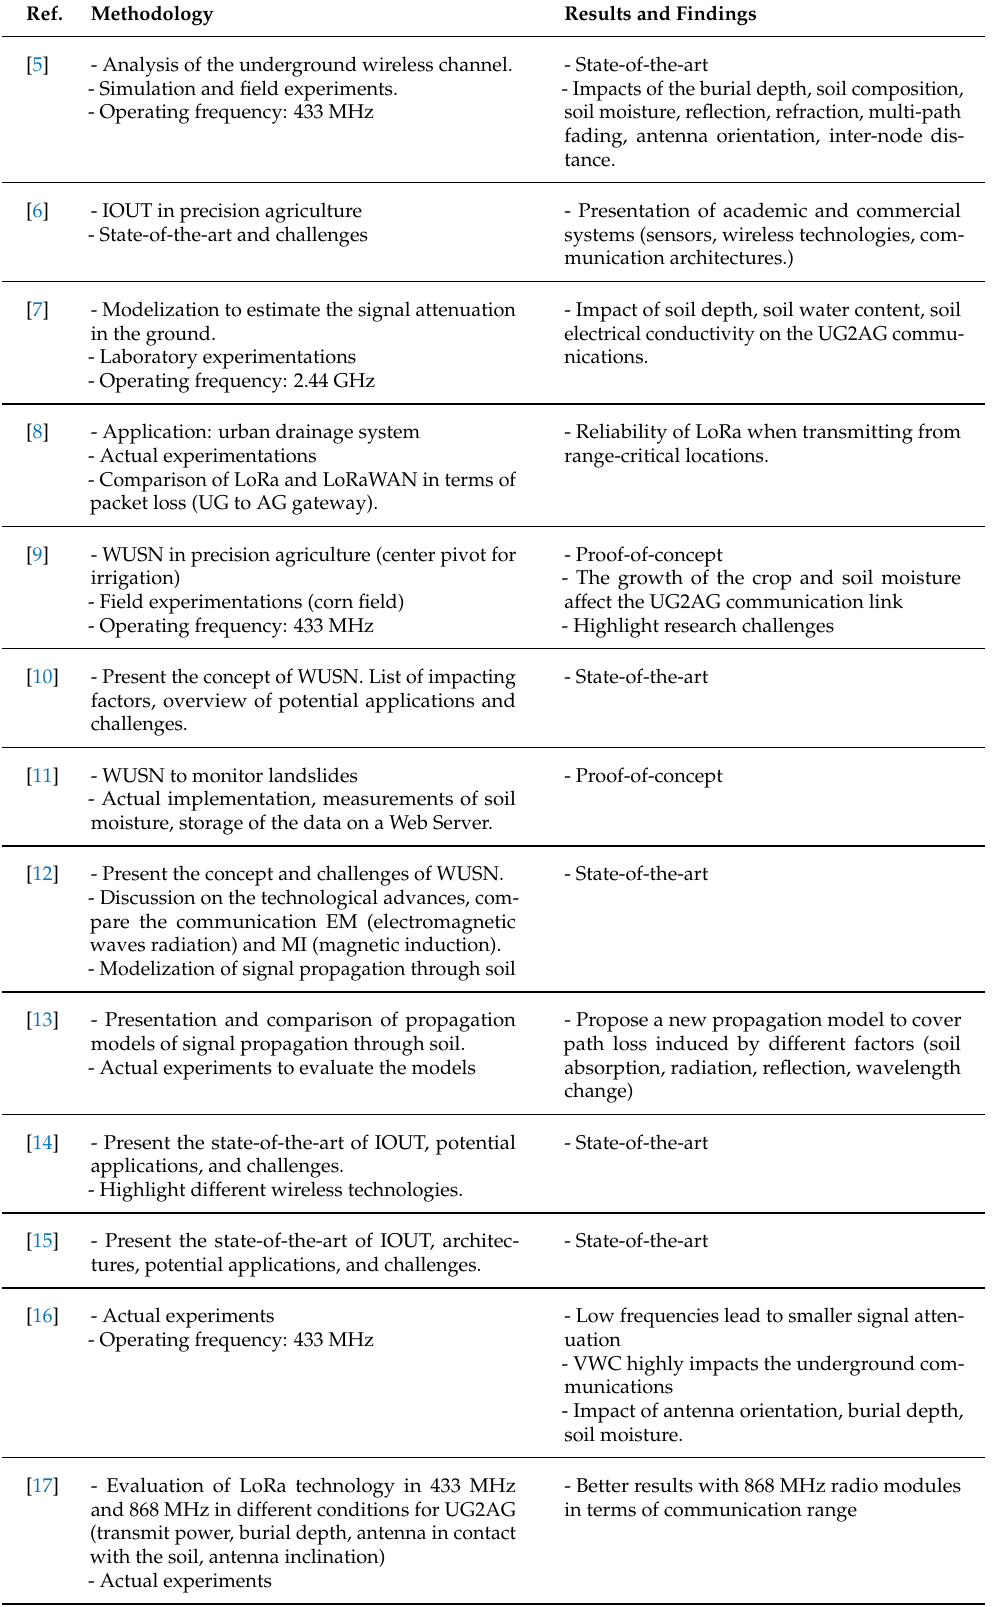
Table A2. Previous research work focused on WSN, WUSN and UAV.